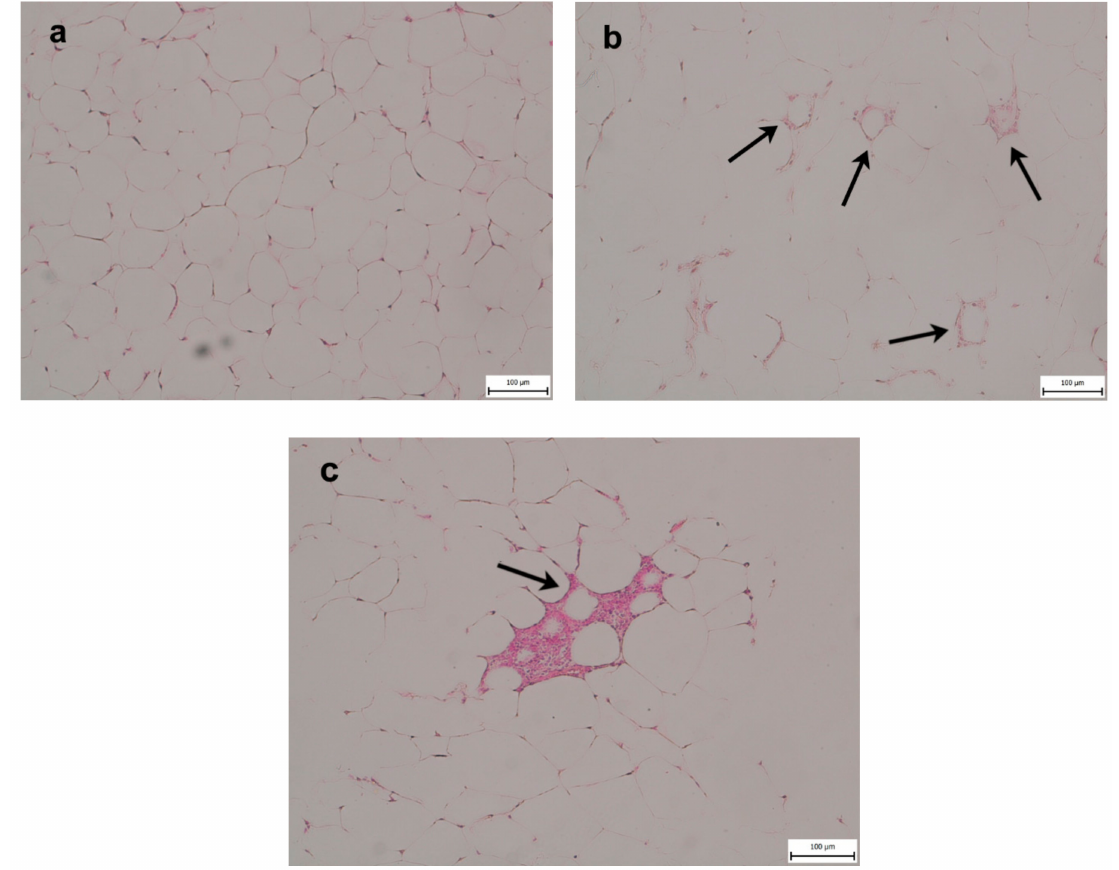
Figure 1. Epididymal fat histology ( a ) in mice fed a control diet (CD) and ( b , c ) Western-style diet (WD). Macrophage infiltration showing formation of crown-like structures (indicated by arrows) characteristic of stressed insulin-resistant dying adipocytes in the WD group. No indications of inflammation are seen in the CD